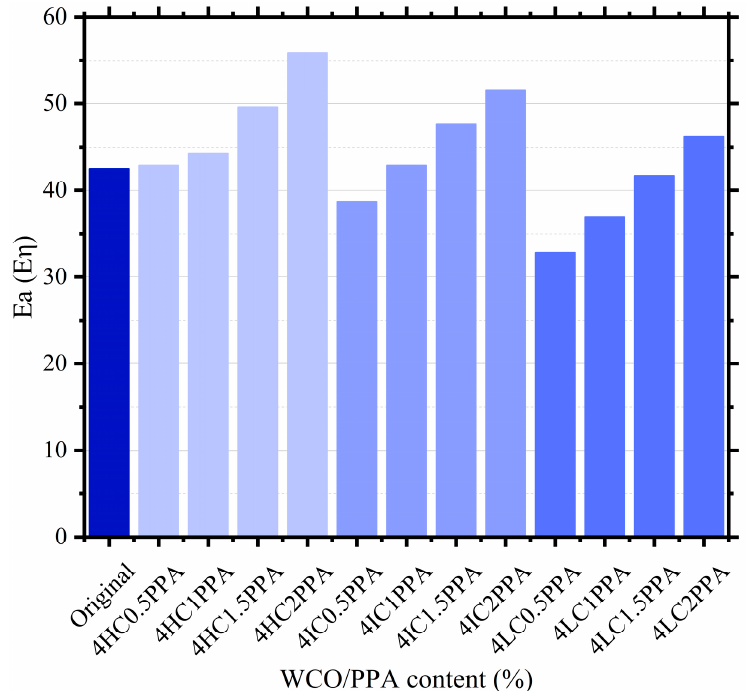
Figure 5. The Ea results of bitumen. Table 5. ASTM Ai-VTSi values for original and modified